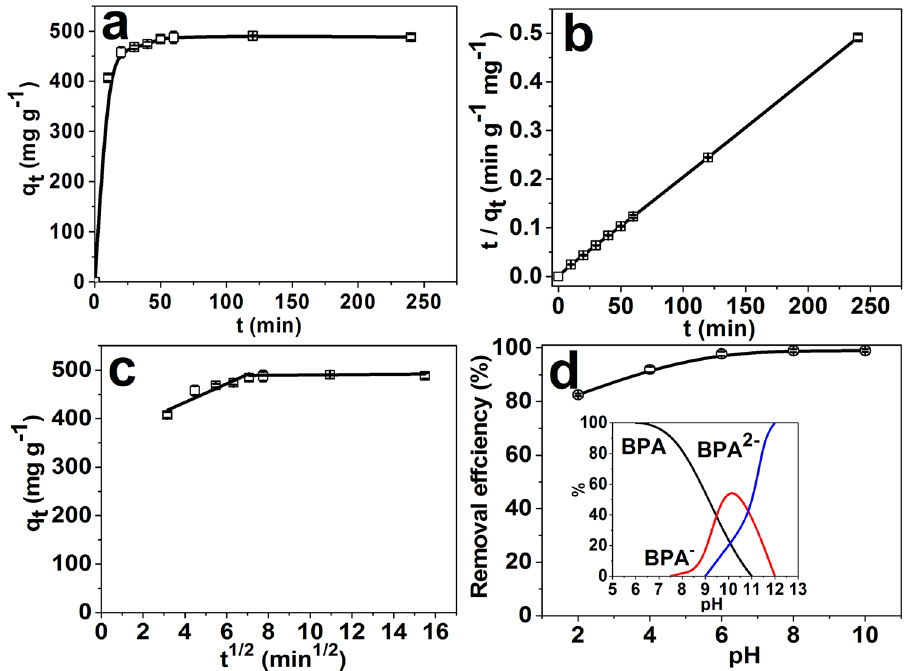
Figure 3. ( a ) The kinetic curve for the adsorption of BPA on PCN-222 at 250 ppm of BPA at 25 °C and pH 8.0. ( b ) Data fitting with pseudo-second-order kinetics model. ( c ) Data fitting with intra-particle diffusion model. ( d ) Effect of pH on the adsorption of BPA on PCN-222 at 25 °C (Sorption conditions: C 0 = 250 ppm, V = 1.0 mL, and m MOF = 1.0 mg). Insert shows the effect of pH on distribution of different BPA chemical